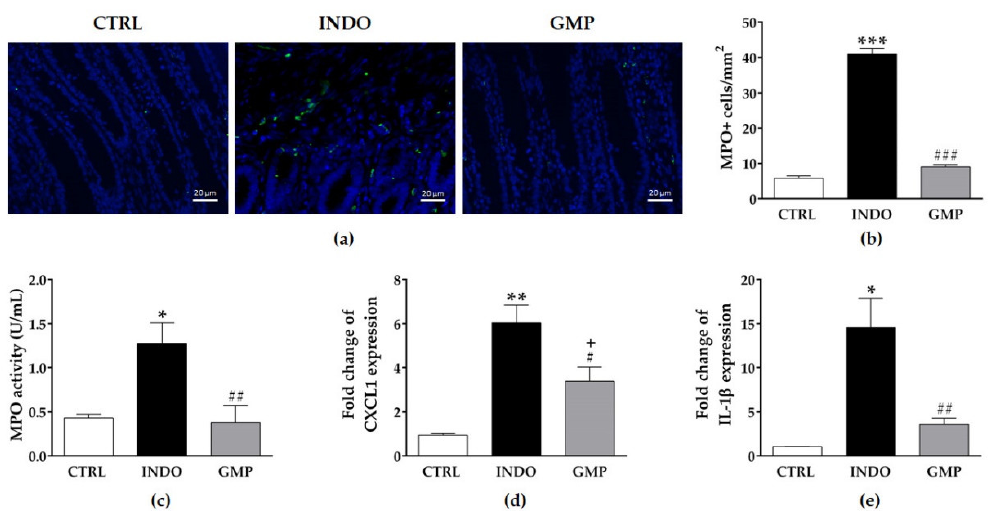
Figure 4. Effect of treatment with glycomacropeptide (GMP) on intestinal inflammation in rats with indomethacin-induced enteropathy. ( a ) Immunofluorescence staining of myeloperoxidase (MPO) positive cells (green) in the intestinal mucosa of rats from the CTRL, INDO and GMP groups (scale bar = 20 µm). The quantity of MPO+ cells per intestinal area unit ( b ) and MPO activity ( c ) in intestinal tissue. Intestinal expression level of CXCL1 ( d ) and interleukin (IL)-1β ( e ) relative to β-actin was analyzed by qPCR and presented as fold change. Data are presented as mean ± SEM. CTRL and GMP, n = 14; INDO, n = 11. * p < 0.01, ** p < 0.001 and *** p < 0.0001 INDO vs. CTRL; # p < 0.05, ## p < 0.01 and ### p < 0.0001 GMP vs. INDO; + p < 0.05 GMP vs. CTRL.